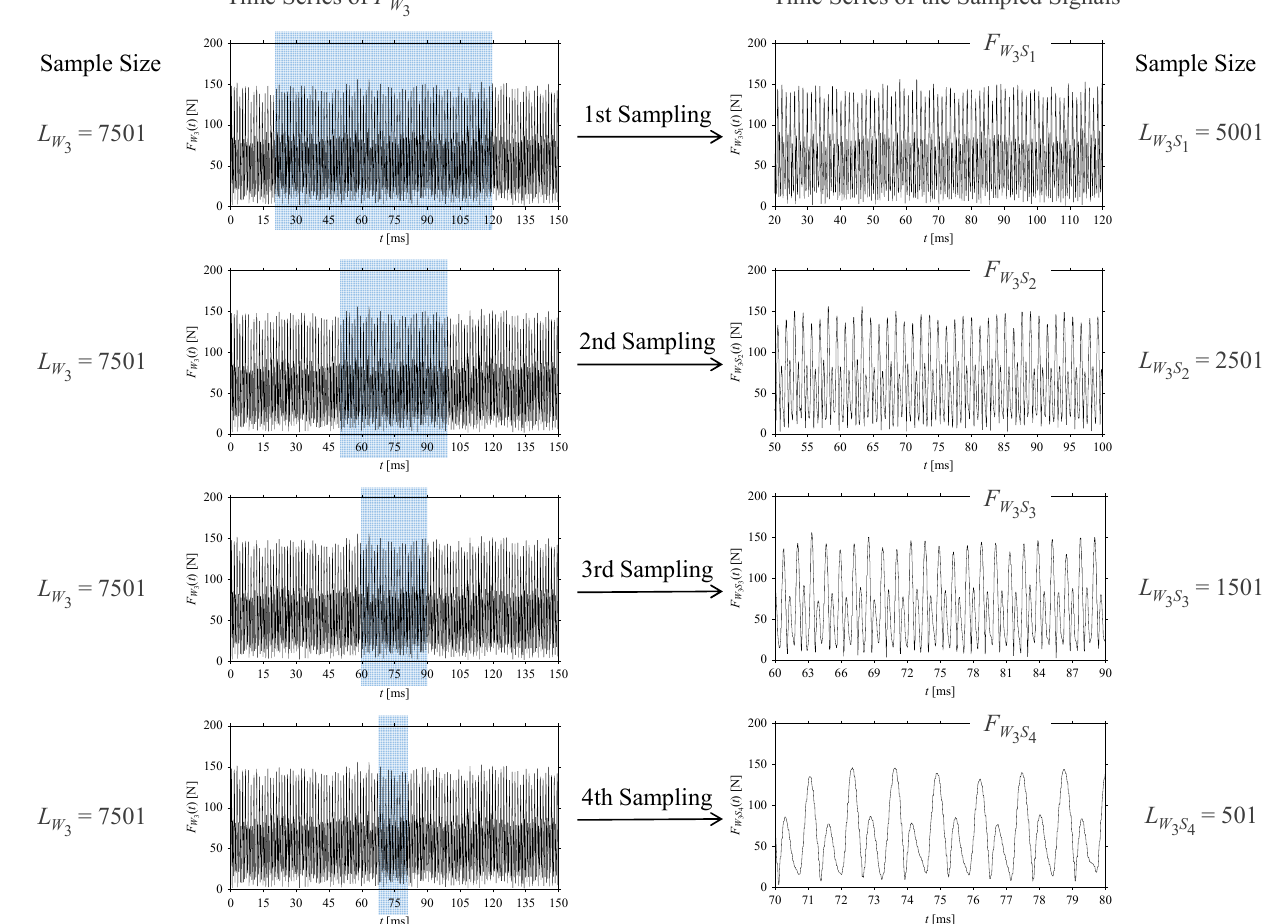
Figure A8. Sampling the cutting force signal for machining ductile cast iron (FCD).